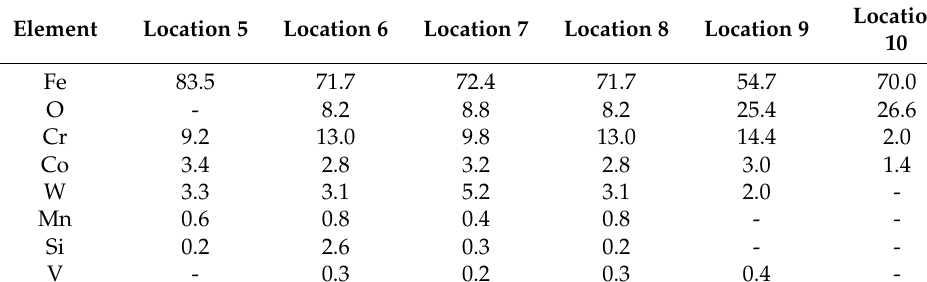
Table 4. Quantitative EDX analysis, MarBN sample oxidized at 600 ◦ C for 2000 h (in wt.%).